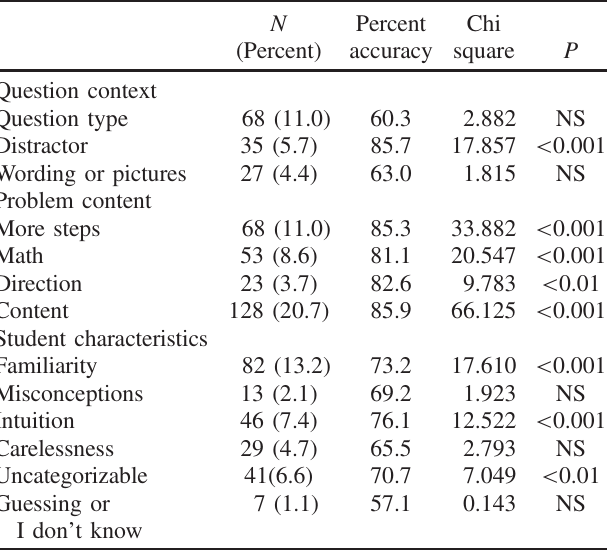
TABLE II. Percentages and chi-square tests of accuracy above chance for PER experts; note df ¼ 1 .